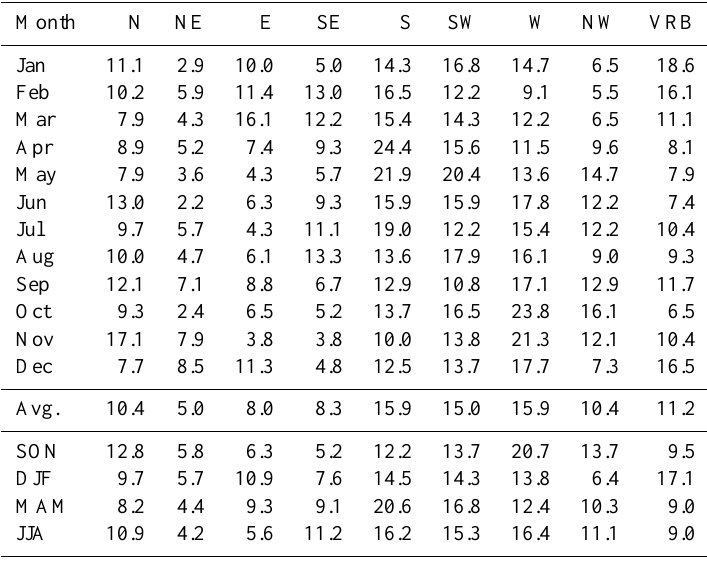
Diurnal range Table 4. Percentage frequency per month (and averaged by season) for qualitative wind direction observations by Reverend Richard Davis for the entire span of his observations. VRB: